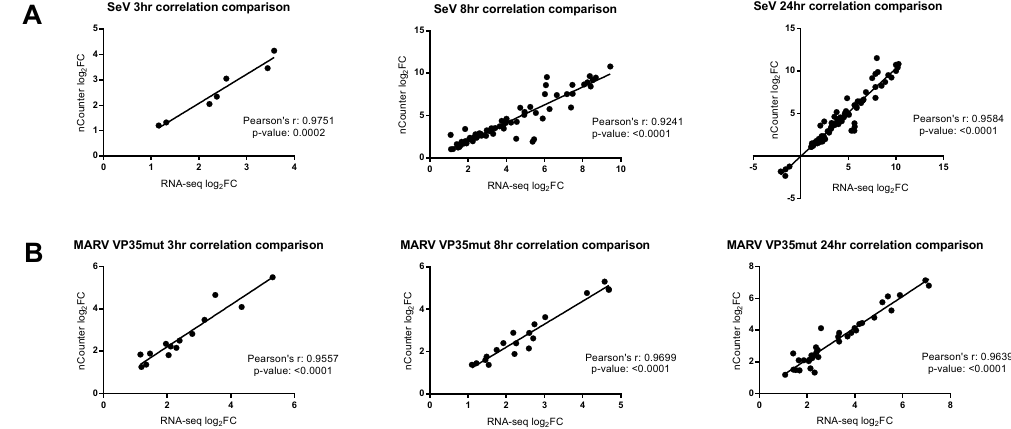
Figure 1. The correlation comparison between nCounter and RNA-seq. DEGs (differentially expressed genes) common to both the transcriptomic platform datasets were graphed against each other. RNA-seq log2FC (fold change) are shown on the x -axis and nCounter log2FC are shown on the y -axis. Pearson’s correlation analysis was performed to determine the relationships between datasets. The line represents the regression analysis. MARV WT correlation comparison is not shown because the two platforms shared no more than one DEG in common. ( A ) SeV comparison is shown for all three time points. ( B ) MARV VP35mut comparison is shown for all three time points.